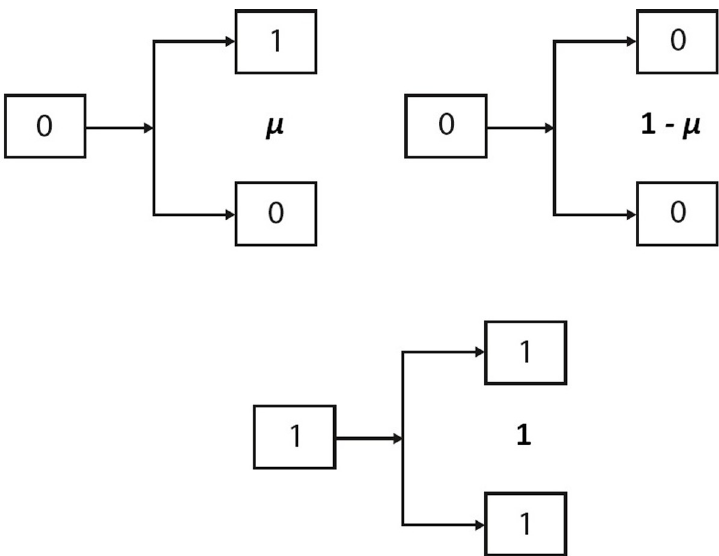
Fig 4. The branching process of cell proliferation with irreversible mutation. Briefly, the cancer cell population is initiated by a single “wild type” (WT) cell, denoted as “0”. At each division, with probability m , one of the WT progeny cells mutates. Mutants, denoted as “1” produce a pair of mutant progeny. Mutants have the same distribution of the interdivision time as the WT cells.